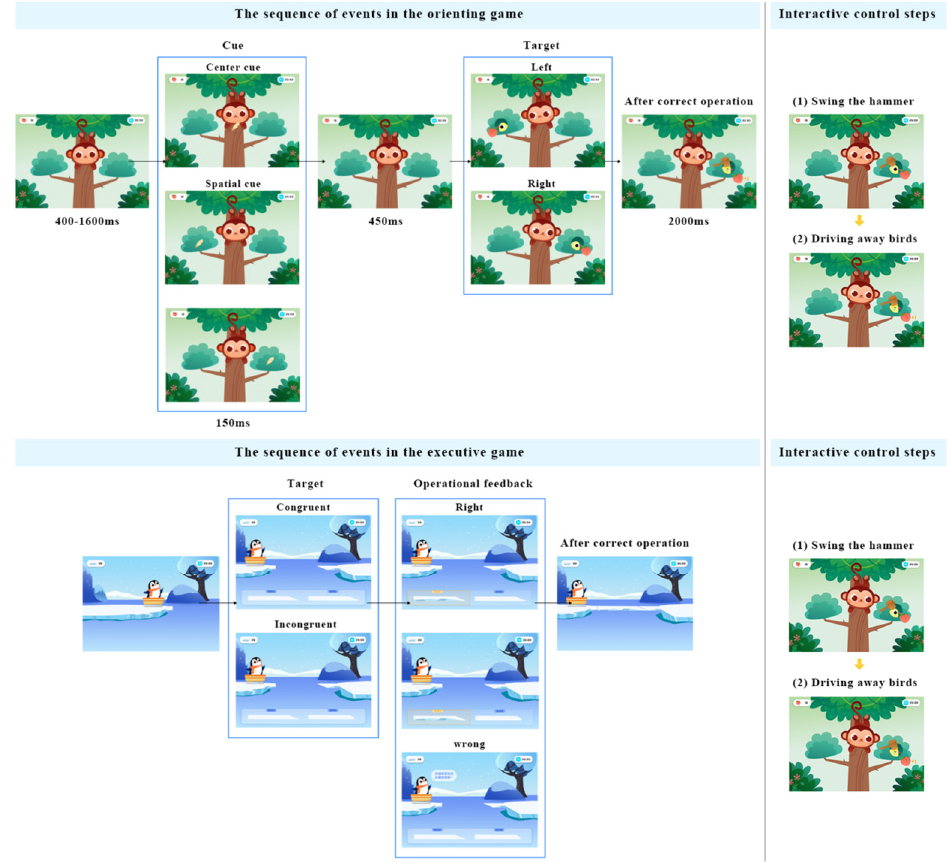
Figure 9. Basic ANT–based game mechanics of the executive and orienting games (authors’ pro ‐ posal).